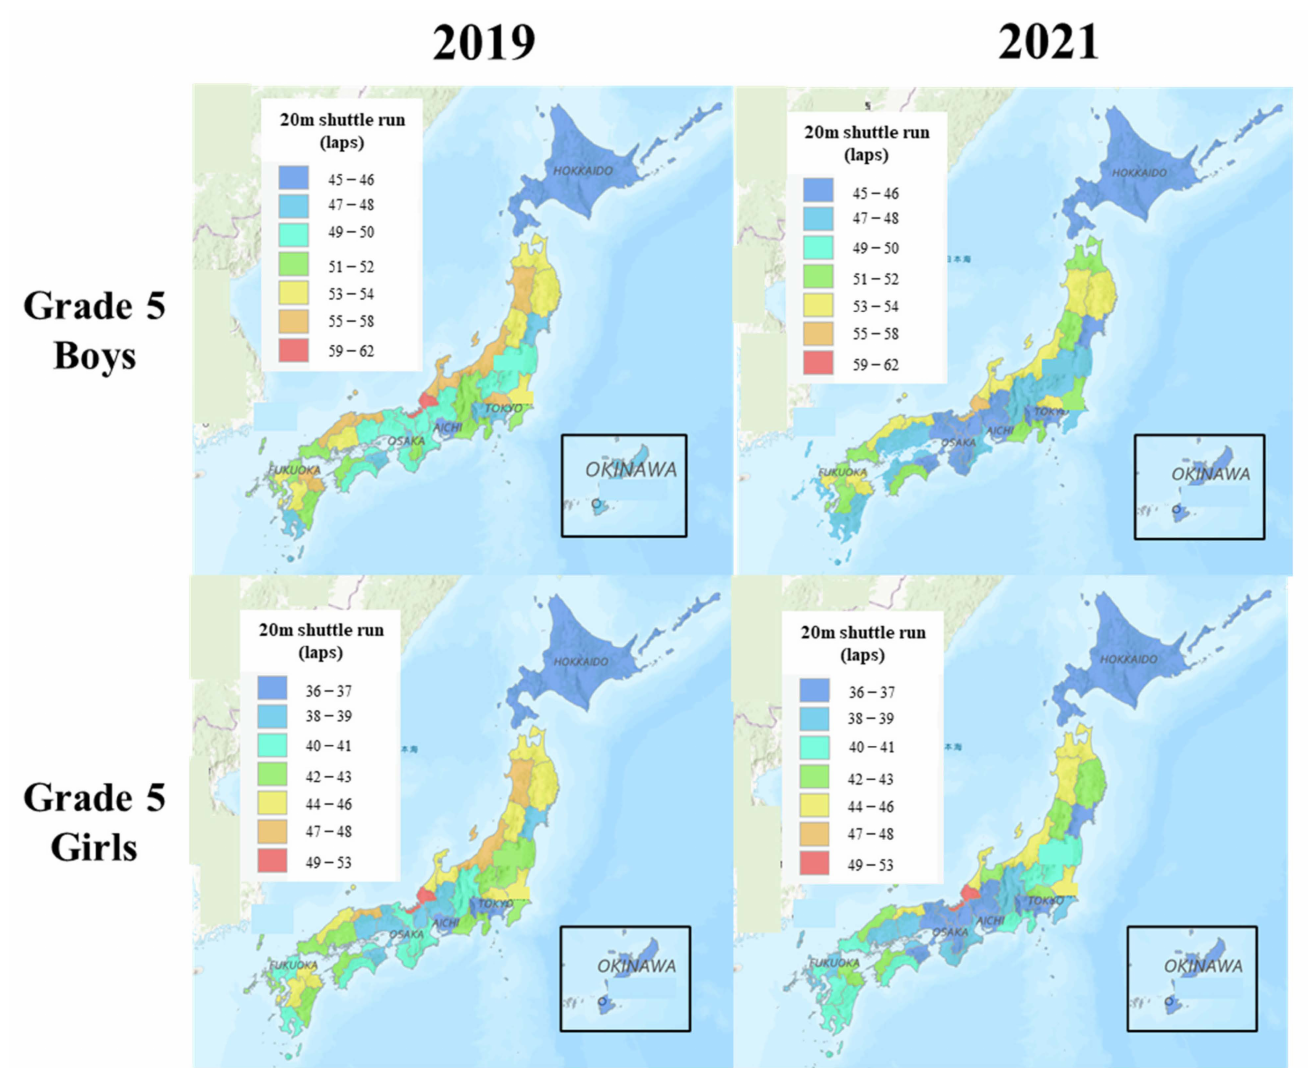
Figure 2. CRF landscapes for Grade 5 students in 2019 and